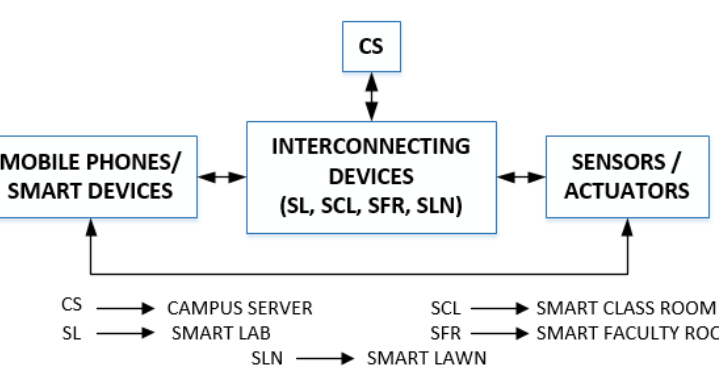
Figure 1. Proposed NDN Based Disaster Management System for Internet of Things based Smart Campus Architecture